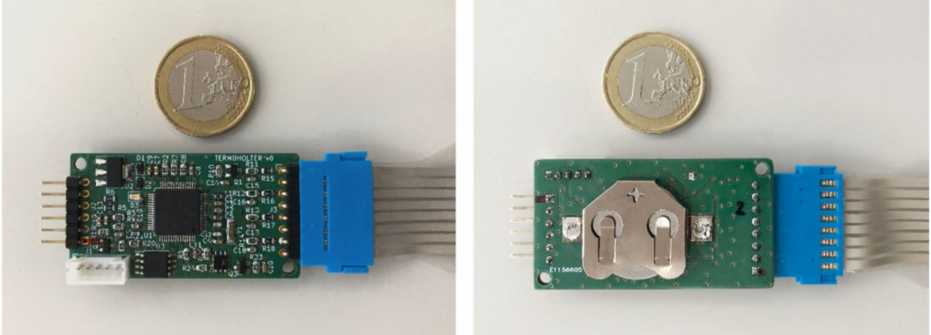
Figure A5. Electronic system (top and bottom views) with the sensor-strip connection.